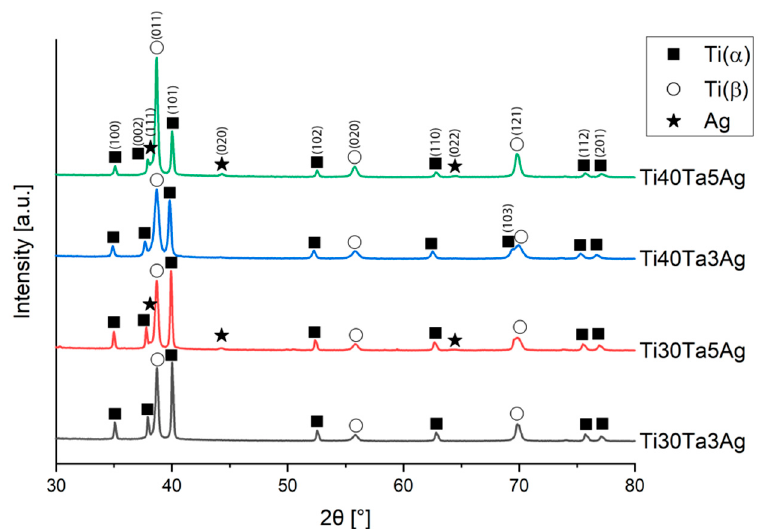
Figure 3. XRD spectra of the hot-pressed Ti-Ta-Ag alloys.